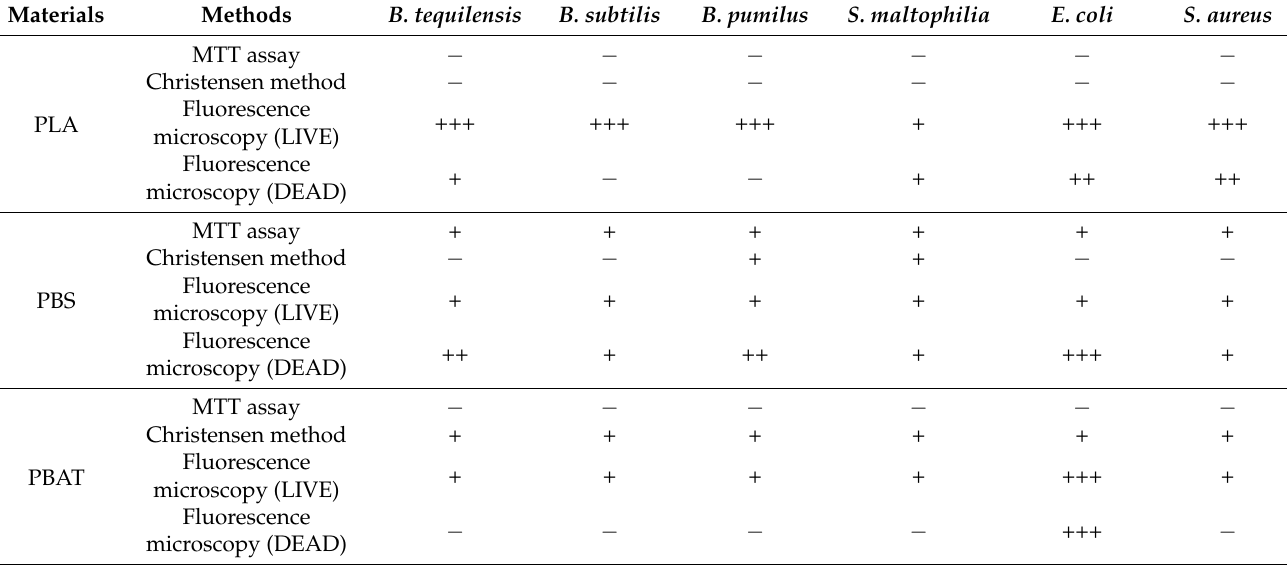
Table 9. Comparison of methods for evaluating biofilm formation for pure materials [78].